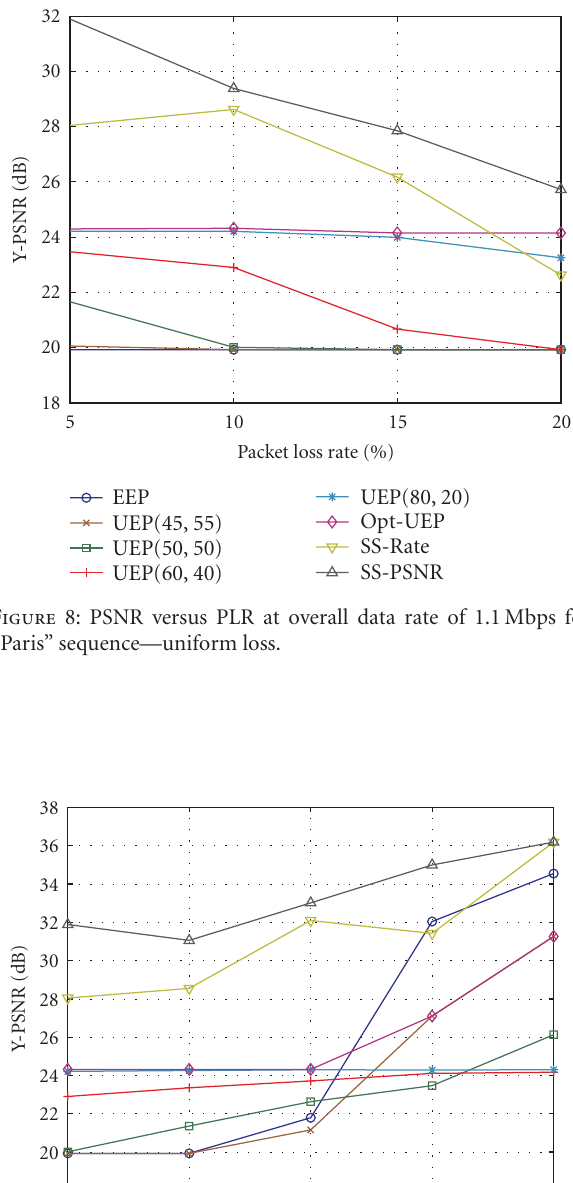
Figure 7: PSNR versus data rate at PLR of 10% for the “Paris” sequence—burst loss.